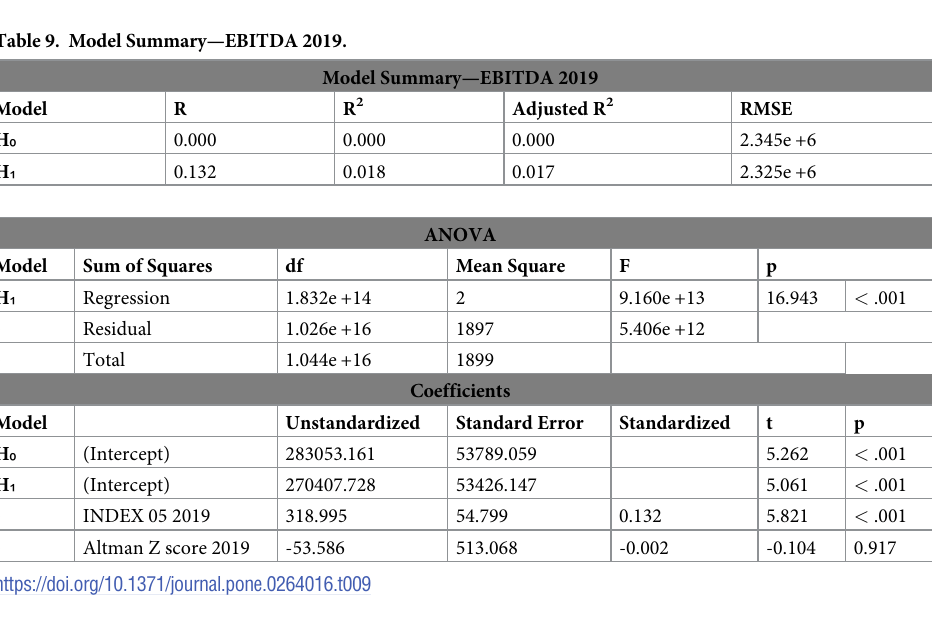
Table 10. Model Summary–EBITDA.